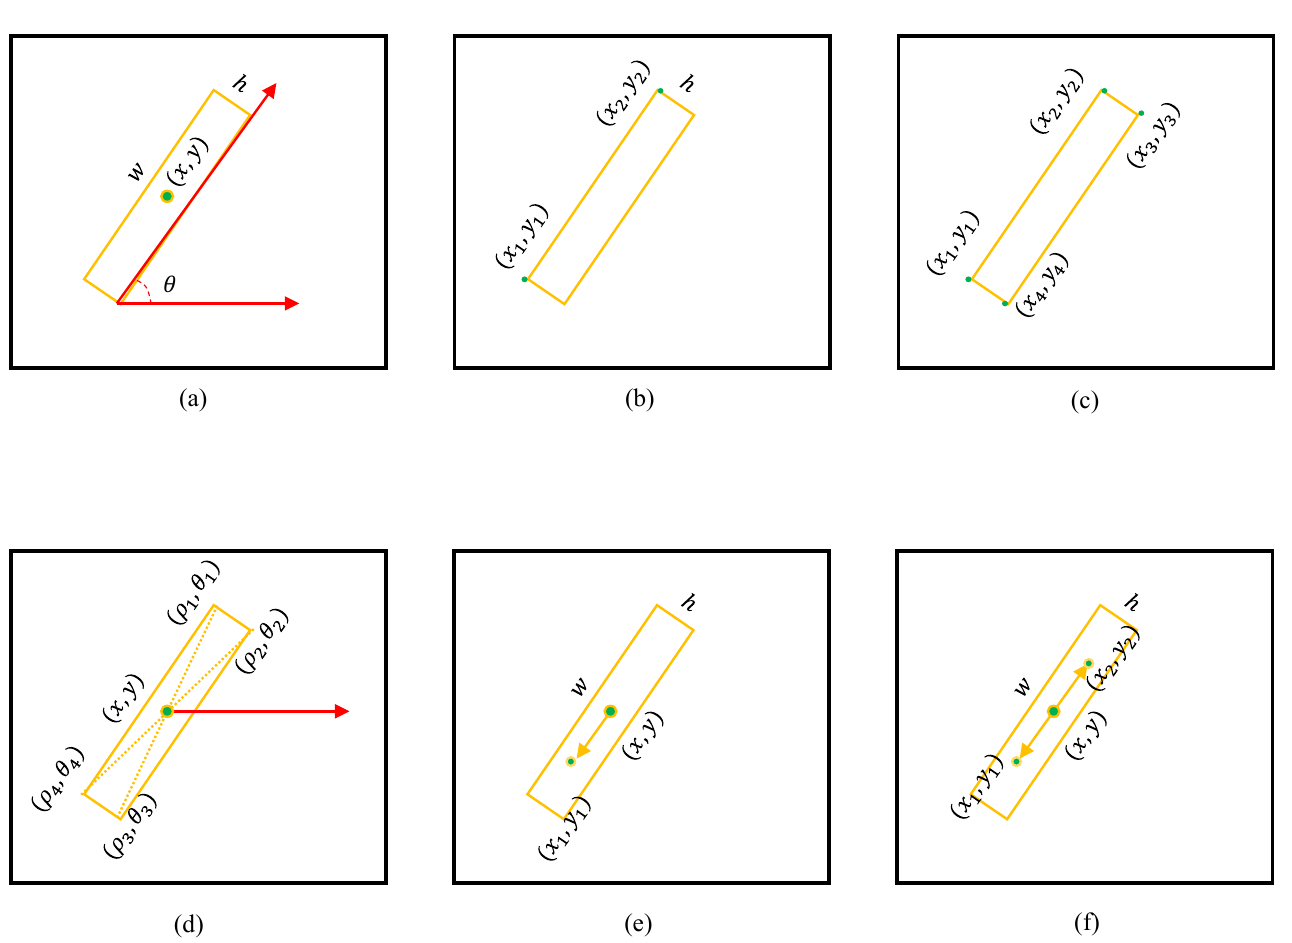
Figure 2. Various representation methods for tilted bounding box. ( a ) ( x , y , w , h , θ ) Five parameters. ( b ) ( x 1 , y 1 , x 2 , y 2 , h ) Five parameters. ( c ) Eight-parameter notation. ( d ) Center polar coordinate representation. ( e ) Single direction vector. ( f ) Tilt dual